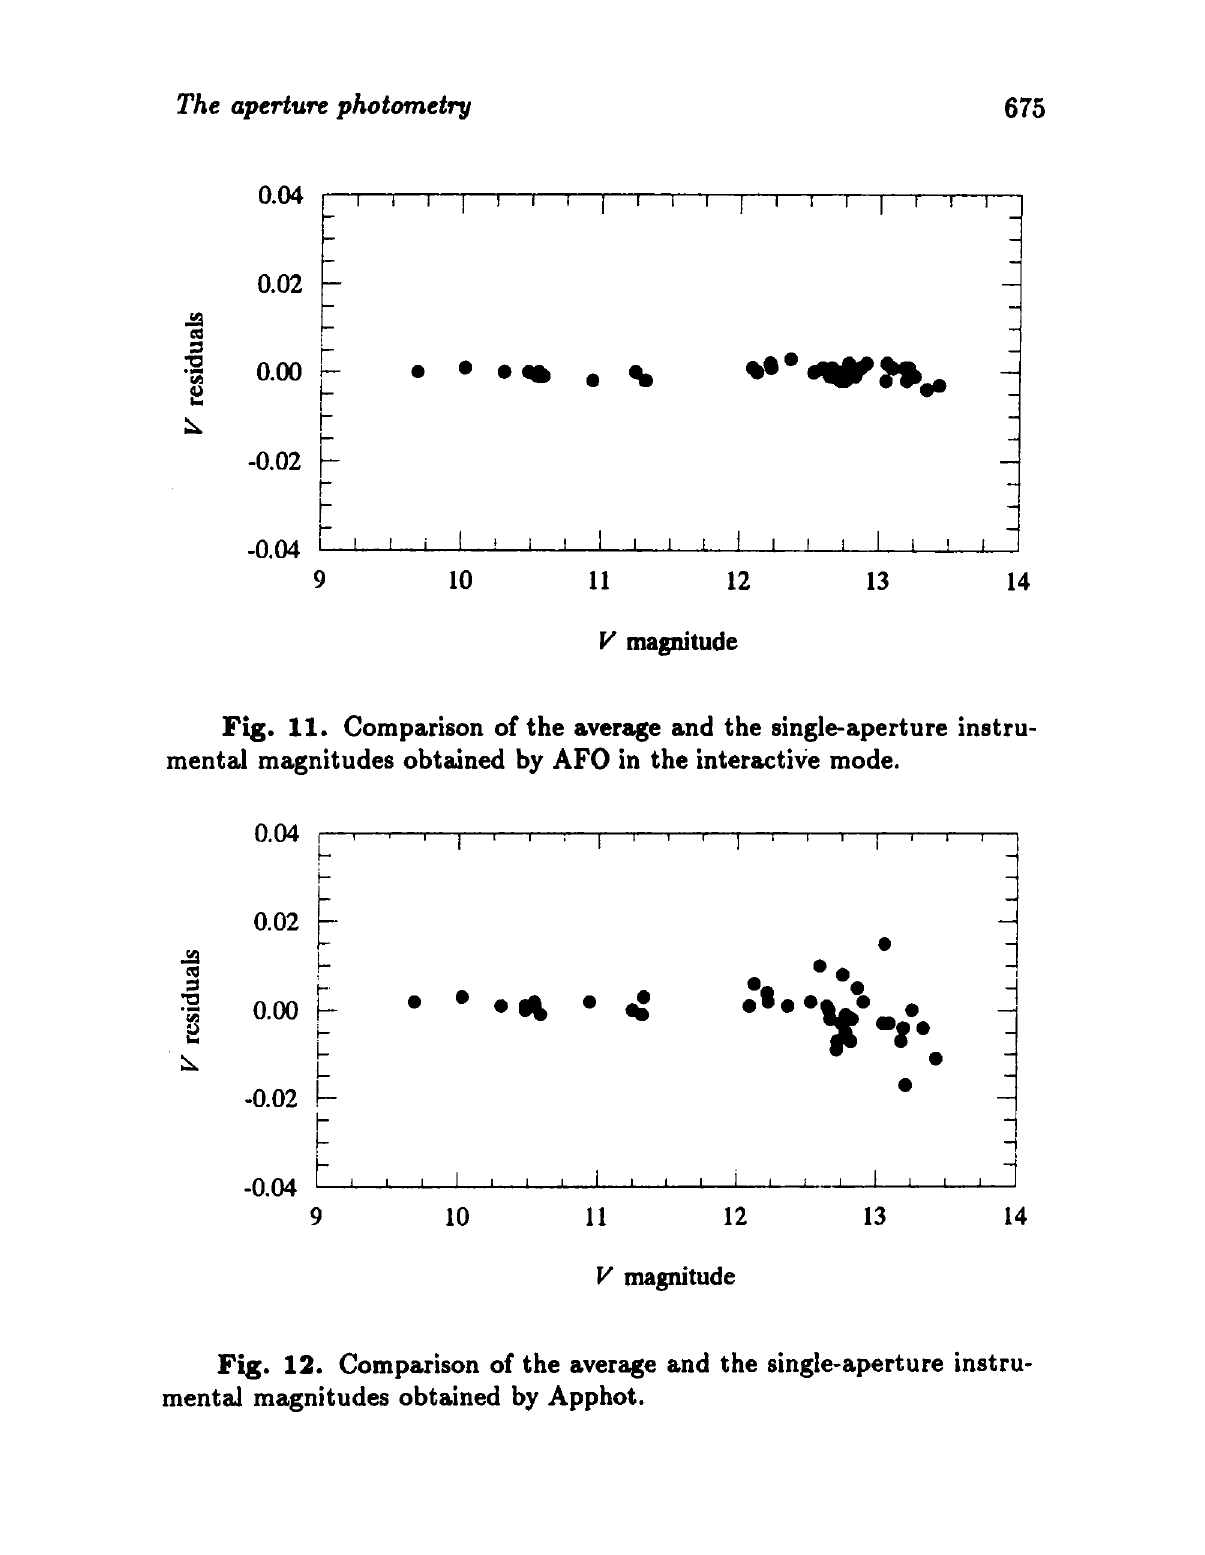
Fig. 12. Comparison of the average and the single-aperture instru- mental magnitudes obtained by